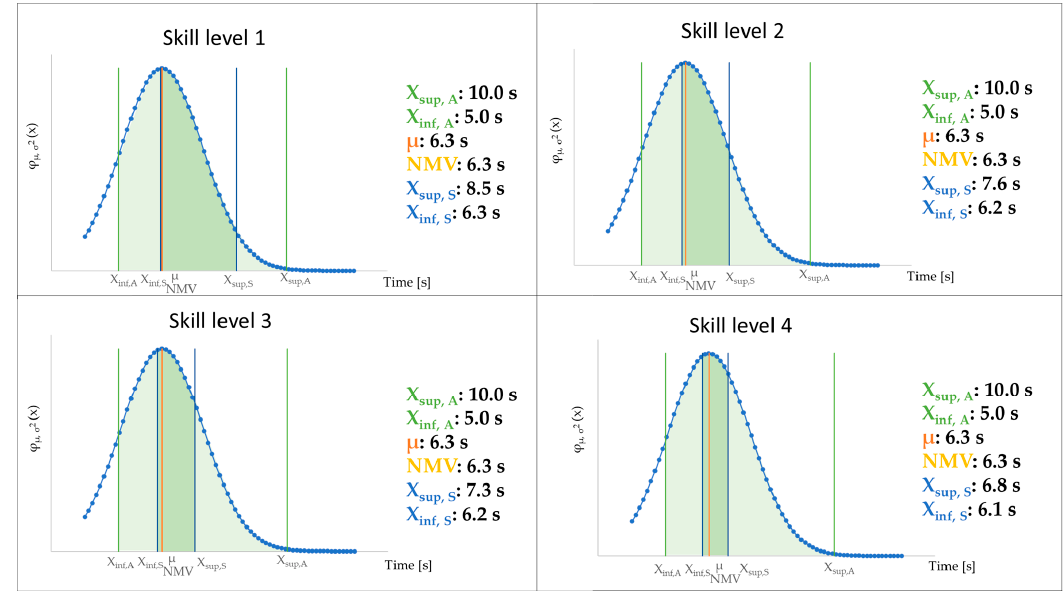
Figure 20. Gaussian distribution of the visual inspection.